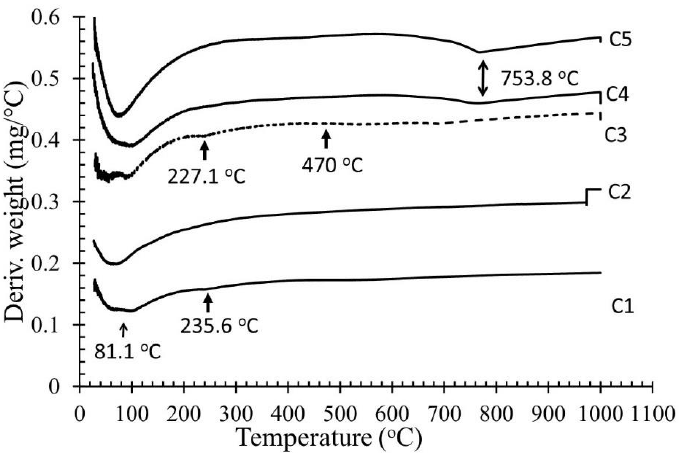
Figure 3. Differential thermogravimetric analysis (dTGA) curves for in the study clays. Figure 3. Di ff erential thermogravimetric analysis (dTGA) curves for in the study